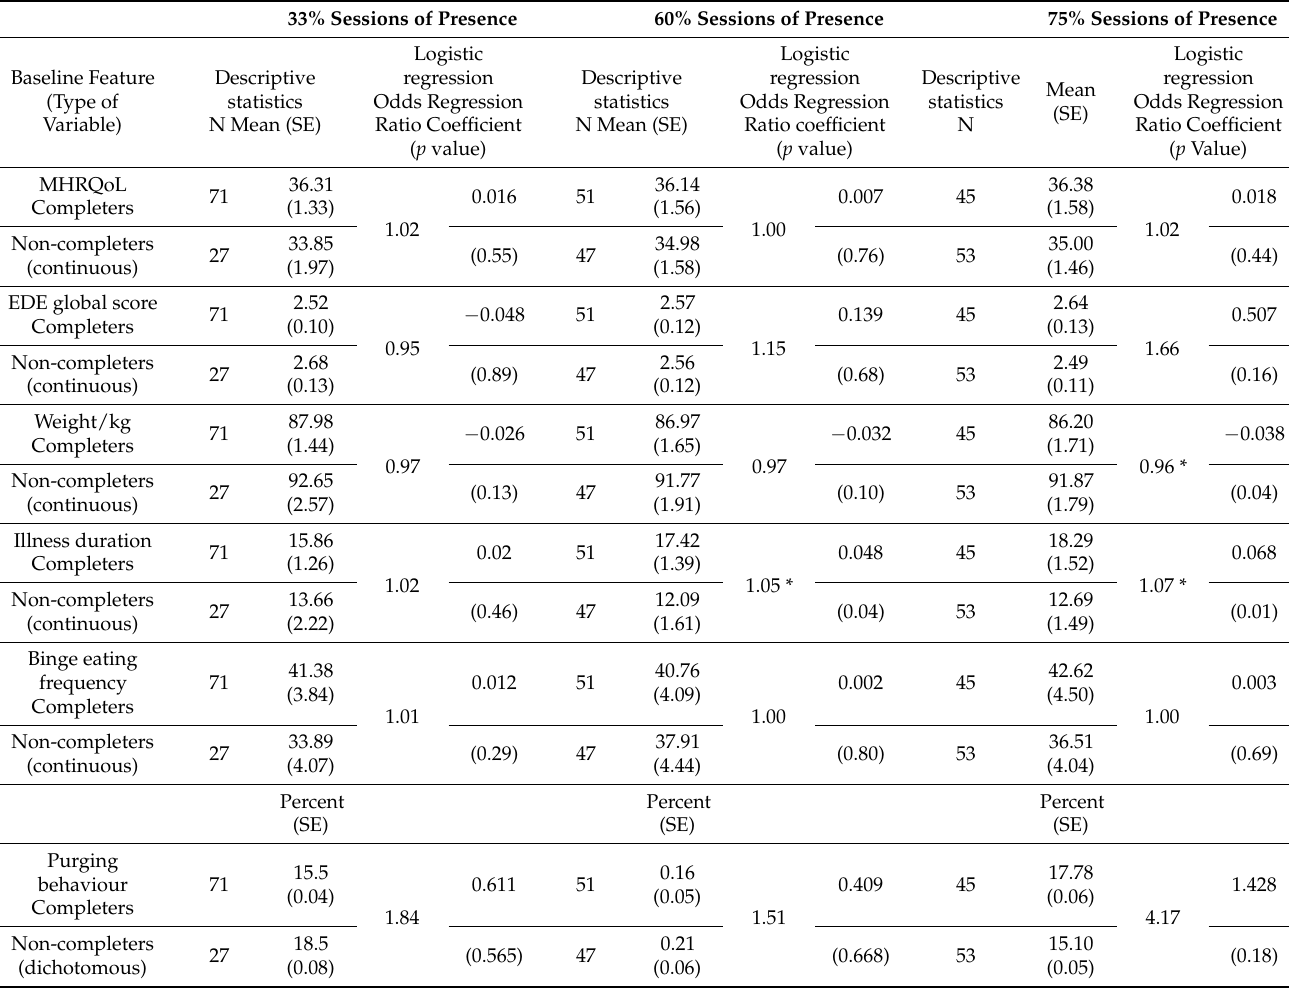
Table 3. Results of descriptive statistics at baseline and logistic regression for presence of 33% sessions, 60% sessions and 75% sessions,